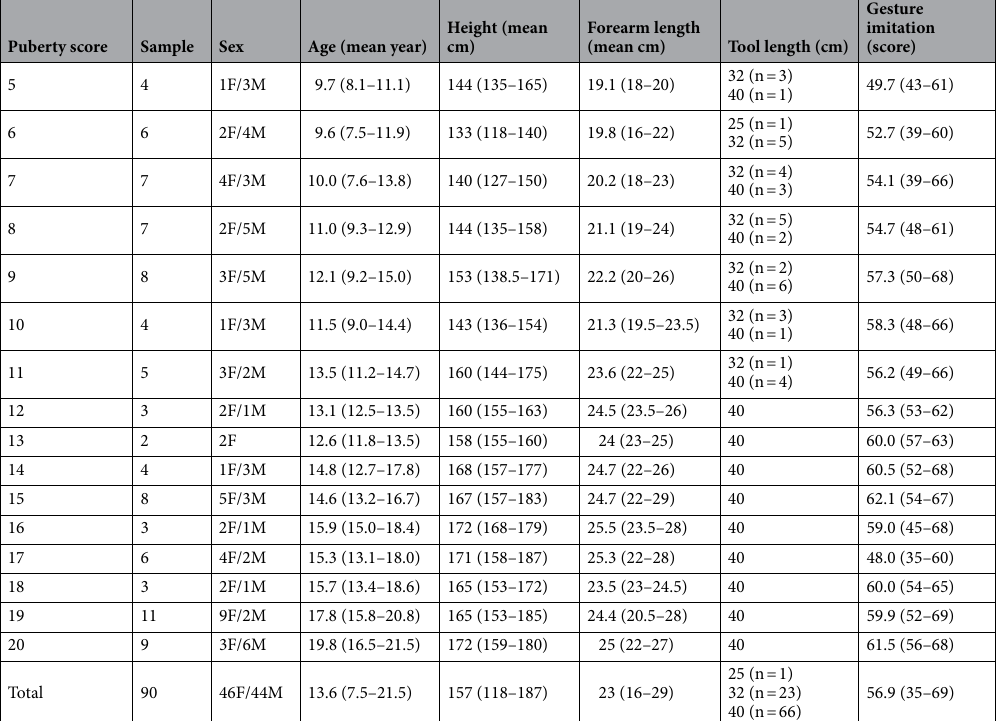
Table 1. Main characteristics of the participants for each puberty score.